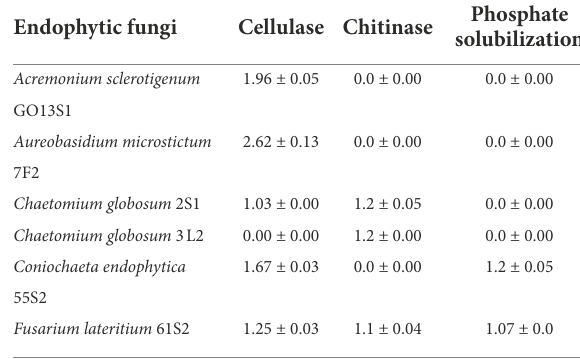
TABLE 3 Phosphate solubilization and enzyme activity of selected isolates.